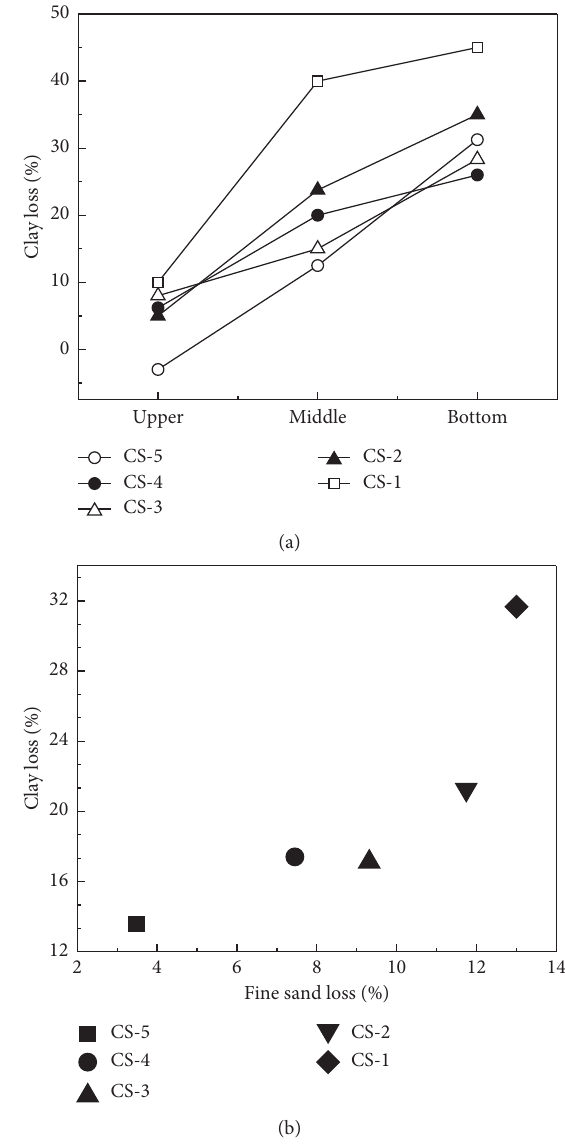
Figure 15: Percentage of clay loss for CS group. (a) Percentage of clay loss. (b) Clay loss variation with fine sand